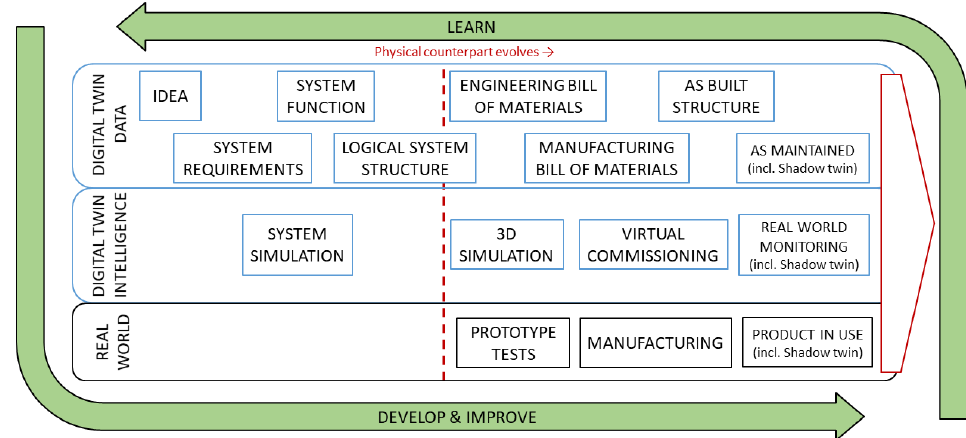
Figure 4. Digital twin-based product lifecycle management from product idea to product in use. The accumulating knowledge is used to develop and improve the product and to learn how to make future products better